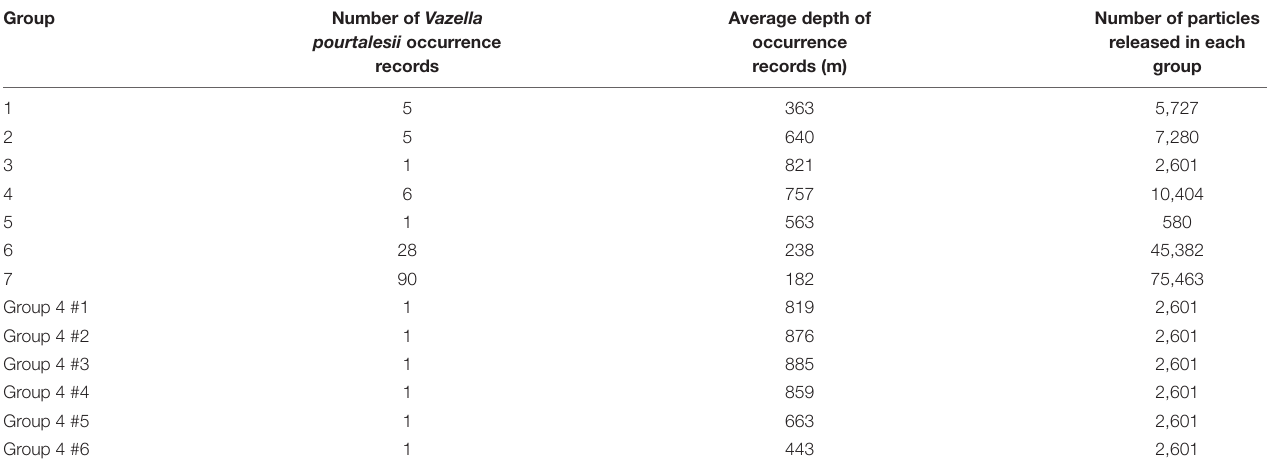
TABLE 1 | Number of Vazella pourtalesii occurrence records, average seabed depth of occurrences, and number of particles released in each simulation model for each of seven Groups, and the six occurrence sites in Group 4. Group Number of Vazella pourtalesii